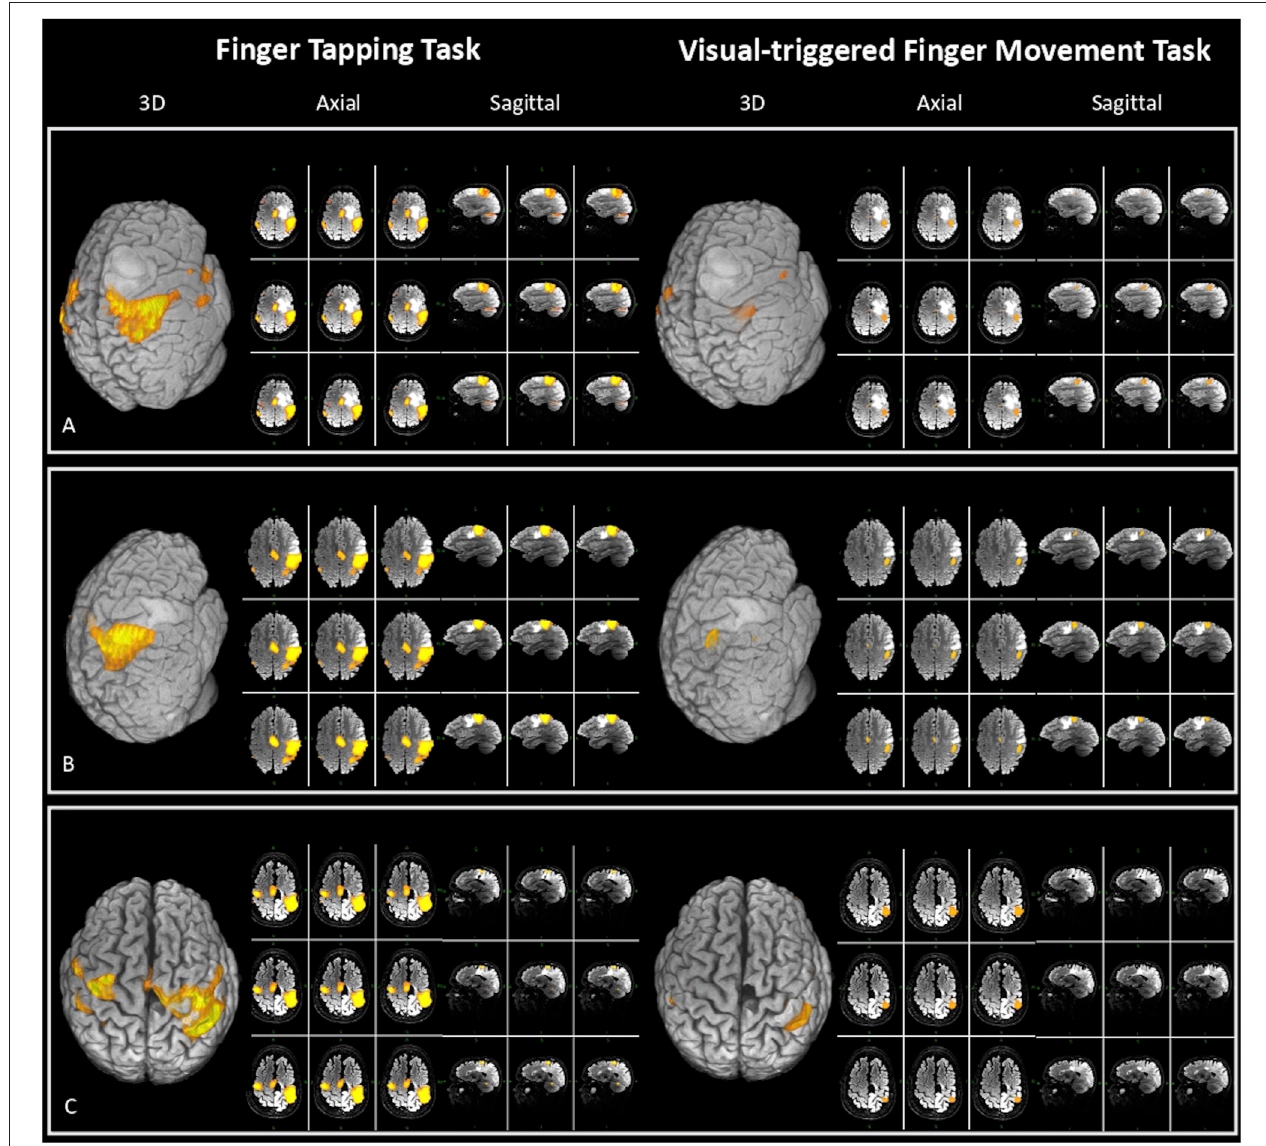
FIGURE 2 | Three-dimensional (3D), axial, and sagittal views of the activation maps for both fMRI tasks [finger tapping task (FTT) on the left and visual-triggered finger movement task (VFMT) on the right], elaborated at single-subject level in three exemplar patients for clinical purpose with BrainWave software on T2 MRI sequences. The figure also displays tumor position and its spatial relation with eloquent areas. (A) Patient 10: closer proximity between lesion and FTT vs. VFMT activation map [fMRI specificity: VFMT 100%; FTT 50%; extent of resection (EOR) 98%]. (B) Patient 20: close proximity between lesion and both fMRI maps < 5mm (EOR 88%). (C) Patient 4: a case of tumor recurrence in which VFMT compared with FTT maps has greater reliability (fMRI specificity: VFMT 100%; FTT 50%) and has a major predictive value on EOR